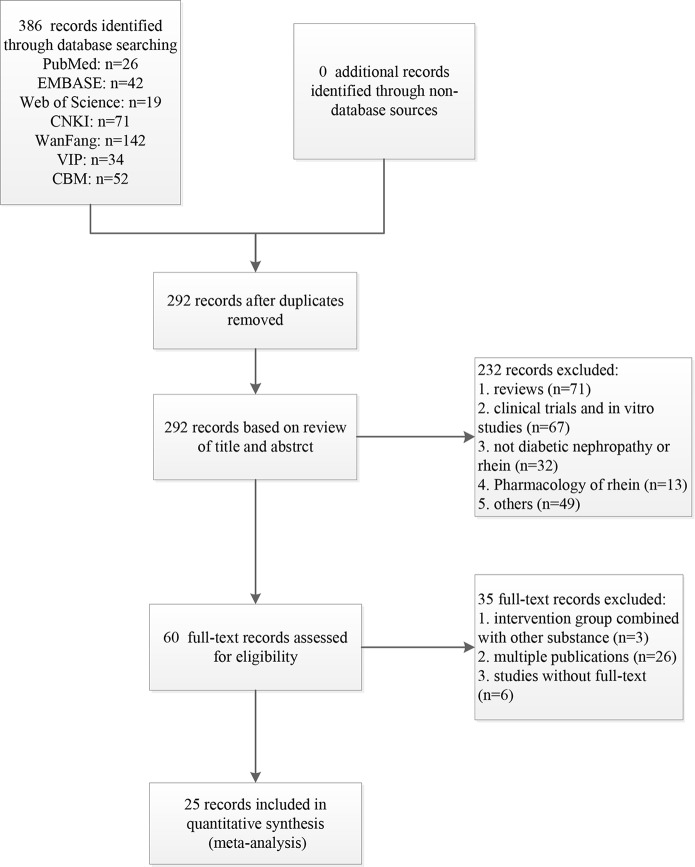
Flow diagram of the study selection process for this systematic review and meta-analysis.